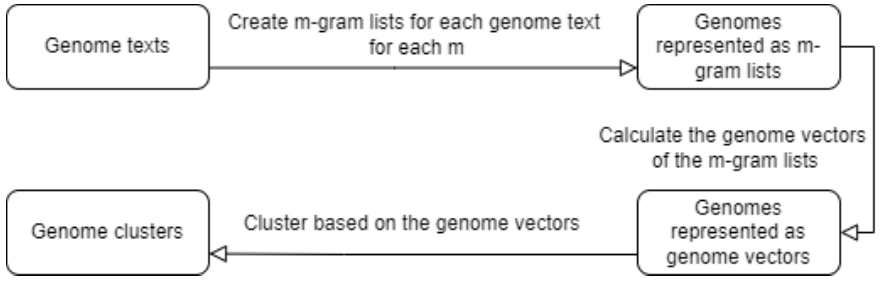
Figure 1. Workflow of the second